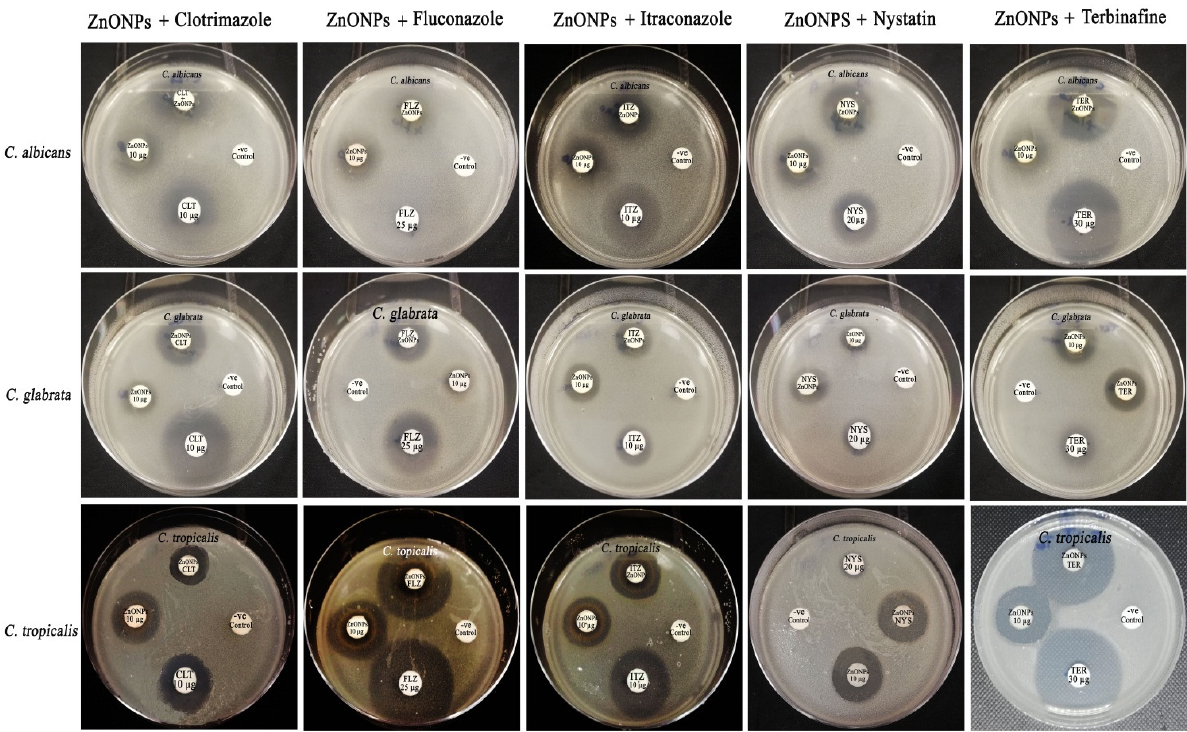
Figure 10. Synergistic antifungal efficiency of the biogenic ZnO NPs with common antifungal agents.